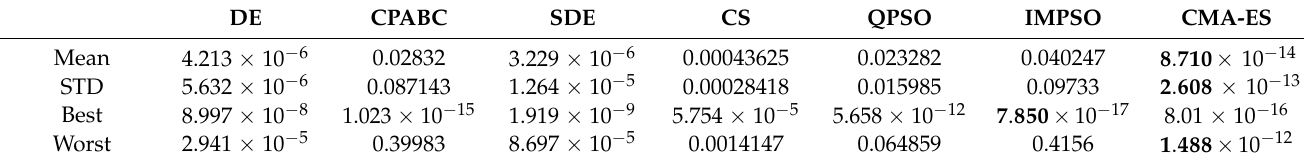
Table 7. Position error results for target point 4. The best results are highlighted in